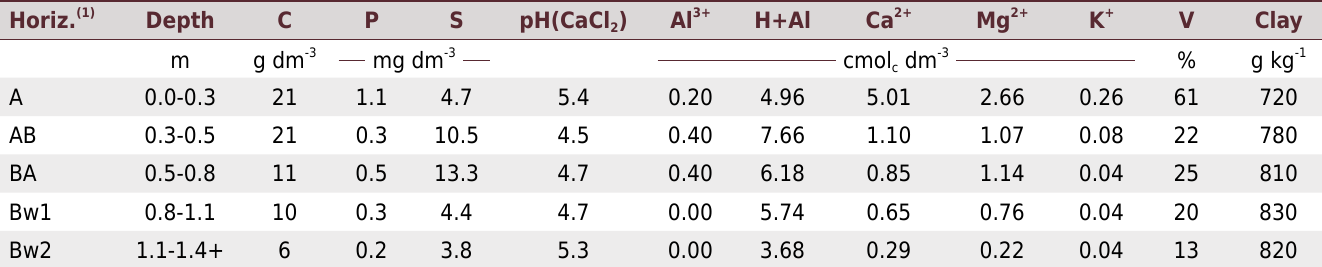
Table 1. Chemical characterization and clay content of a Typic Hapludox profile before the experiment in October, 2009